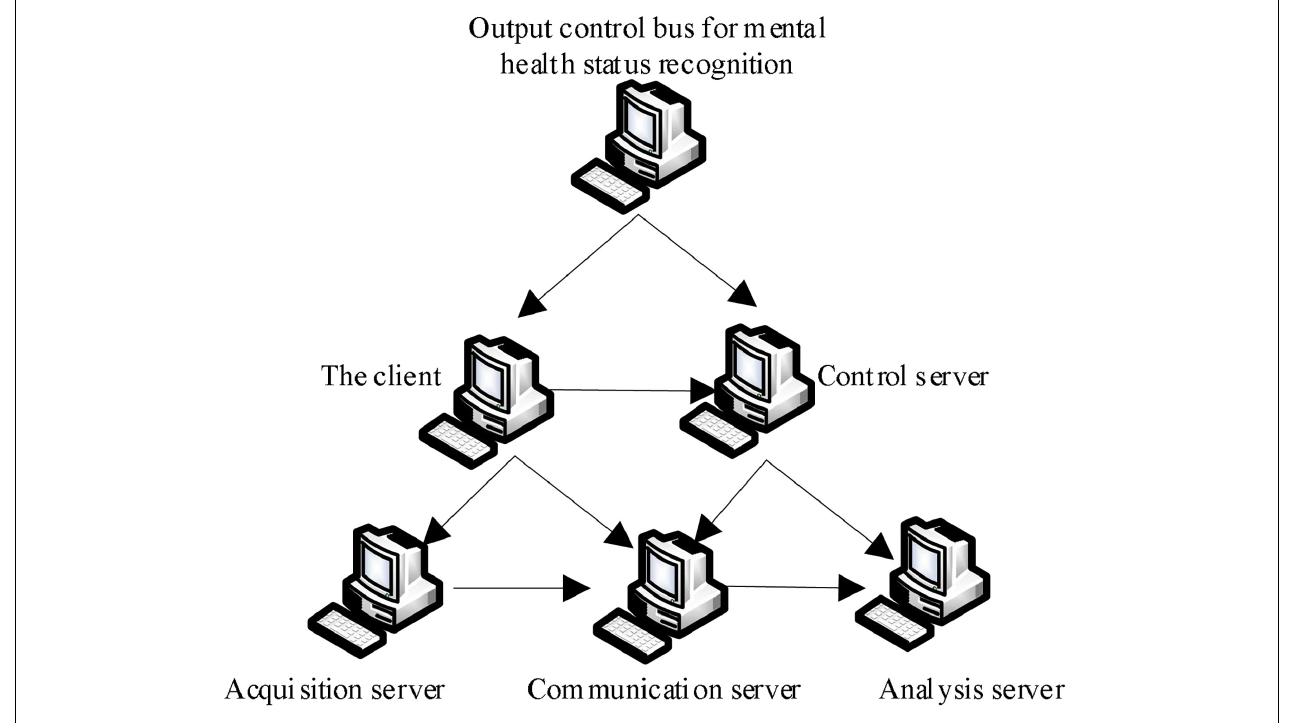
FIGURE 7 | Simulation experiment environment diagram.